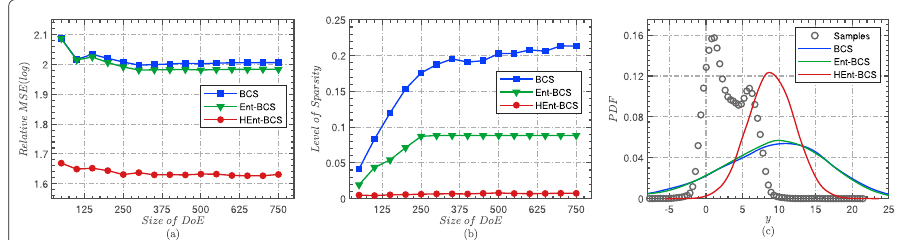
Fig. 9 Performance comparison of BCS, Ent-BCS and HEnt-BCS w.r.t. the OAKLEY & O’HAGAN function. ( a ) The relationship between the relative MSE and the size of DoE; ( b ) The relationship between the